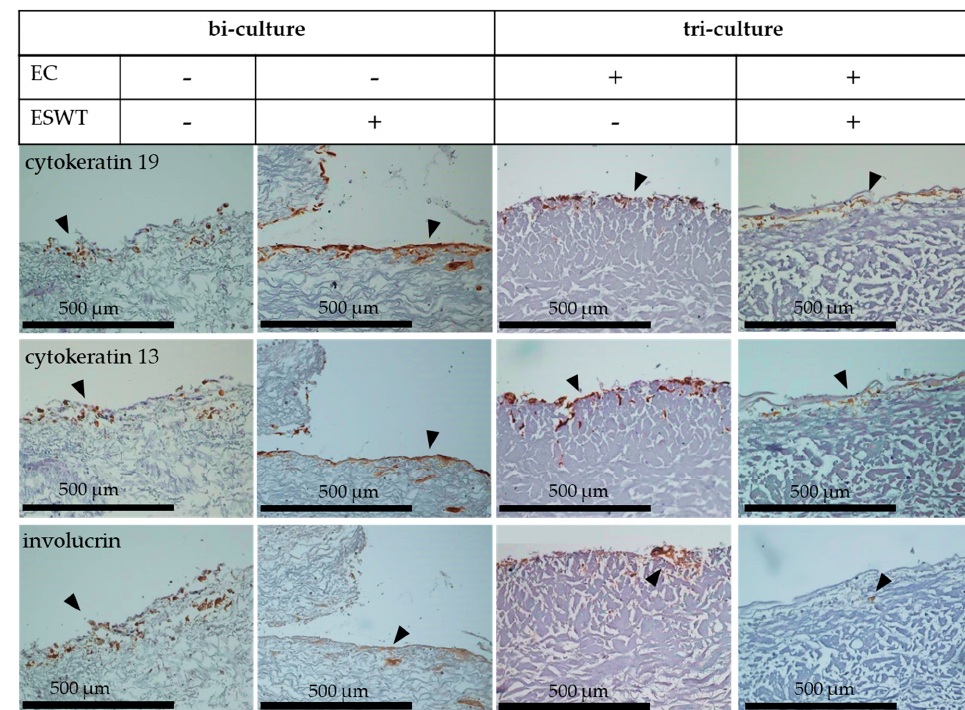
Figure 8. Formation of a multilayered epithelium in bi-cultures (fibroblasts and epithelial cells) and in oral mucosa equivalents (tri-cultures of fibroblasts, epithelial cells, and endothelial cells) in ovo after treatment with ESWT on culture day 19. The formation of the multilayered epithelium of tissue equivalents on the chorioallantoic membrane (CAM) was examined in ESWT treated and untreated bi-cultures of fibroblasts and epithelial cells, and in ESWT treated and untreated oral mucosa equivalents (tri-cultures) of fibroblasts, epithelial cells, and endothelial cells (EC). Cytokeratin 19 was used as a marker for undifferentiated basal epithelial cells (arrows), cytokeratin 13 for suprabasally differentiating epithelial cells (arrows), and involucrin for fully differentiated epithelial cells (arrows). Consecutive sections from the samples were used for the staining with different antibodies. In the images, the cell occlusive side of the collagen matrix is directed upwards, and the porous side directed downwards. The bi-cultures and oral mucosa equivalents were analyzed by immunohistochemistry. Scale bars represent 500 µ